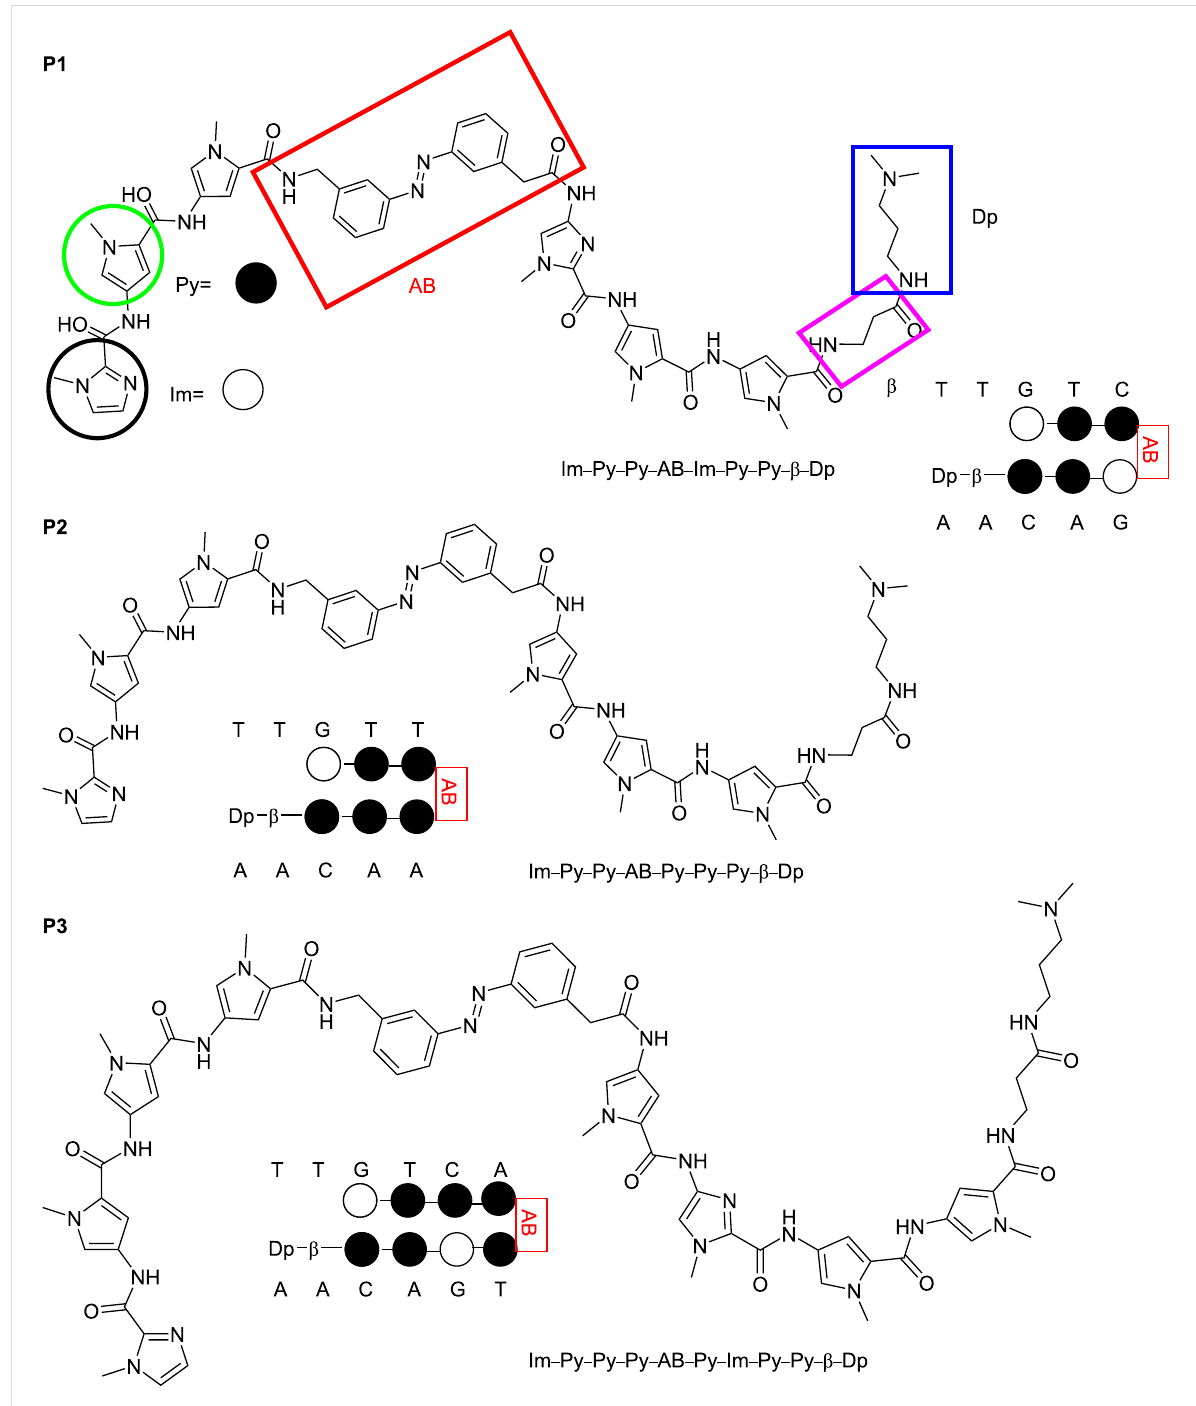
Scheme 1: Pyrrole–imidazole–azobenzene polyamides and the dsDNA target sequences employed in this study.